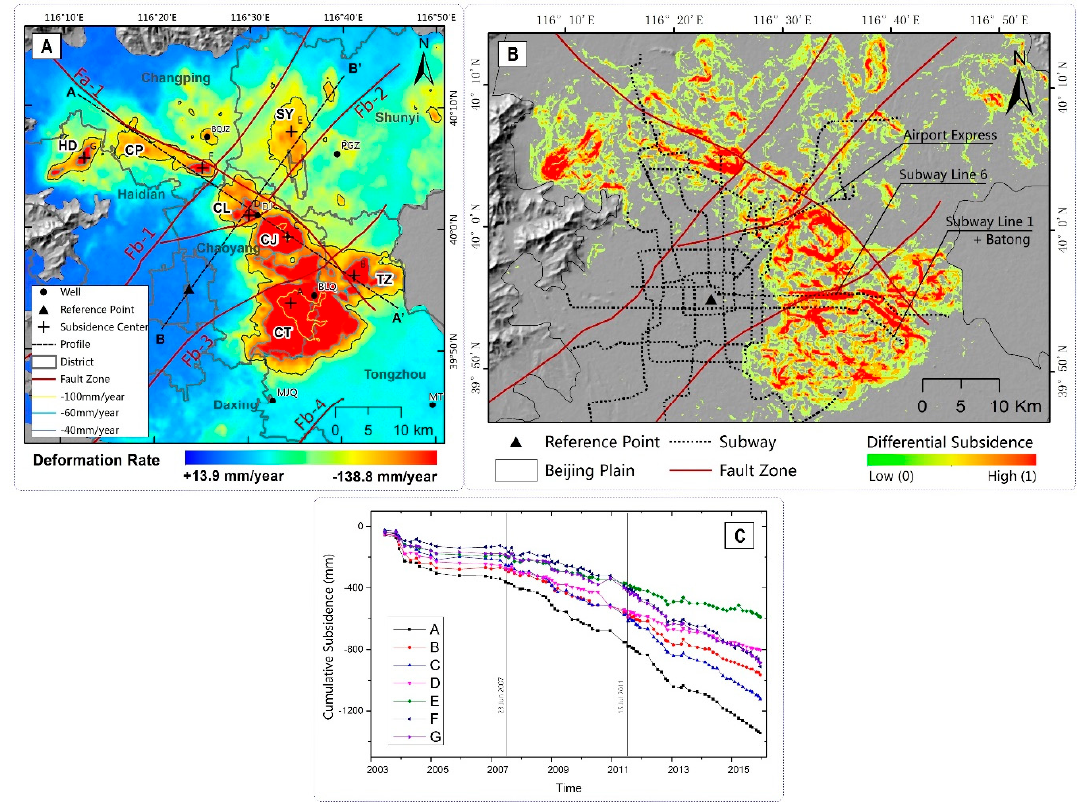
Figure 11. Land subsidence induced by the withdrawal of groundwater from the Beijing Plain,